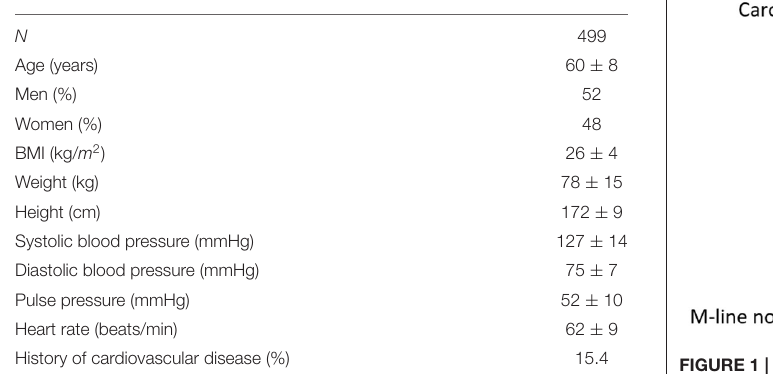
TABLE 1 | Characteristics of the study population.